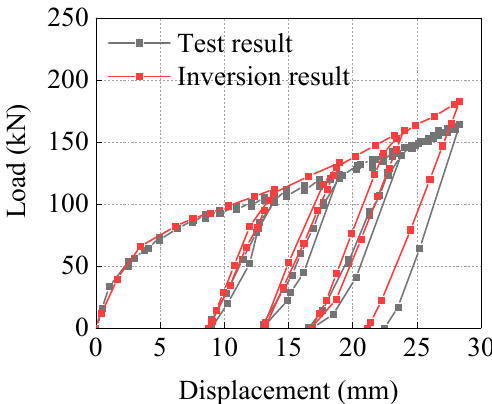
Figure 5. Comparison of load–displacement curves.